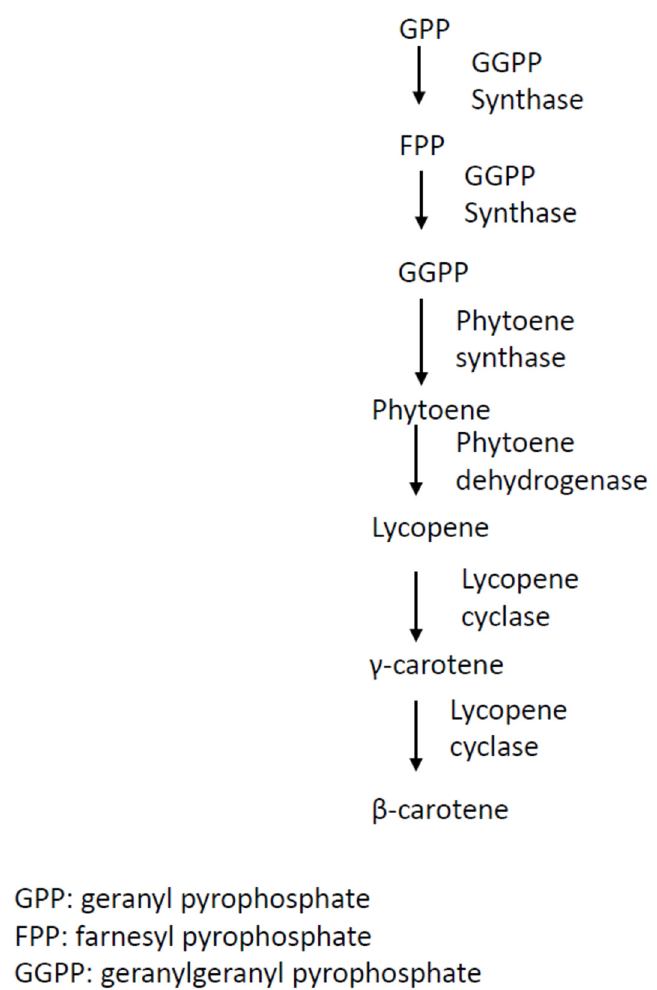
Figure 1. Biosynthesis pathway of β -carotene in Blakeslea trispora. This schematic pathway was drawn based on information reviewed in reference [34].